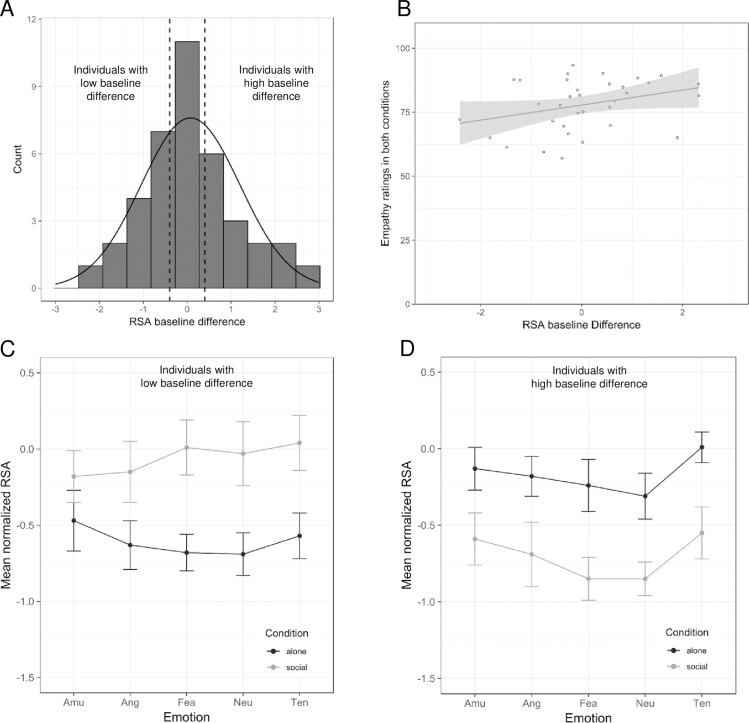
Results of the RSA analyses.(A) Distribution of baseline differences in RSA between social and alone condition. (B) Correlation between baseline differences in RSA and empathy ratings for characters in the film scenes (r = .32, p = .06). The shaded area represents the 95% confidence region. (C, D) Mean RSA values per emotion in both conditions in individuals with low RSA baseline differences (C) and in individuals with high RSA baseline differences (D), respectively. Amu = amusement; Ang = anger; Fea = fear; Ten = tenderness; Neu = neutral; RSA = respiratory sinus arrhythmia. Error bars represent the standard error of the mean.